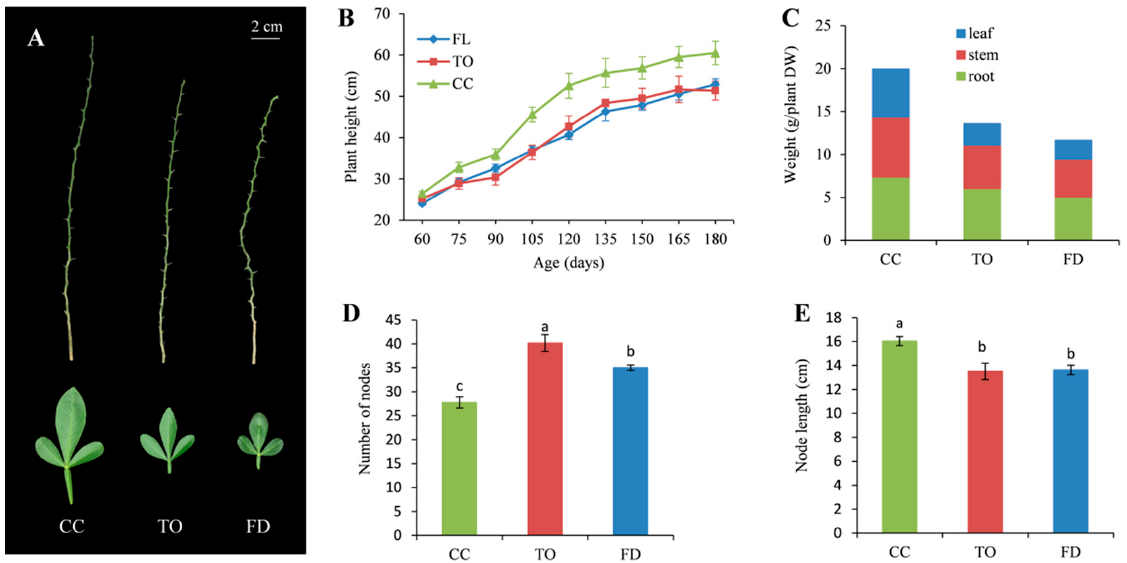
Figure 1. Stem and leaf morphology ( A ), dynamic change in plant height ( B ), weight of different parts of the plant ( C ), number of nodes in the stem ( D ), and node length ( E ) of the CC, TO, and FD rootstocks. Different small letters indicate significant differences at p < 0.05 according to Duncan’s multiple range tests.